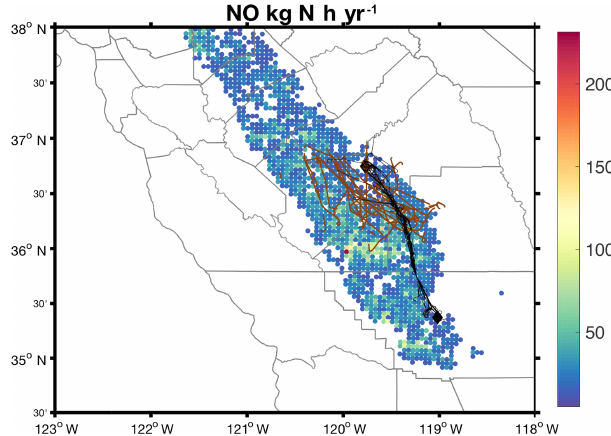
Figure 3. Soil NO emissions in kilograms of nitrogen per hectare per year for the SJV with flight tracks (data from Almaraz et al., 2018). Significant sources for soil NO show up in the middle SJV in Kings County. EPA (brown) and RLO (black) flight paths are also